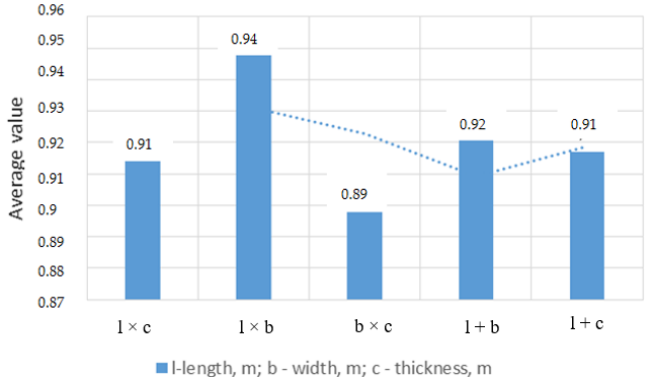
Figure 7. A histogram of the correspondence of the separation of potato tubers by values. To determine the above analytical dependence, experimental studies were conducted to determine the dimensional and mass characteristics of potato tubers of the varieties “ Nevsky ” and “ Red Scarlet ” in a 3-fold repetition of 800 measurements, the dispersion diagrams of which are shown in Figure 8.